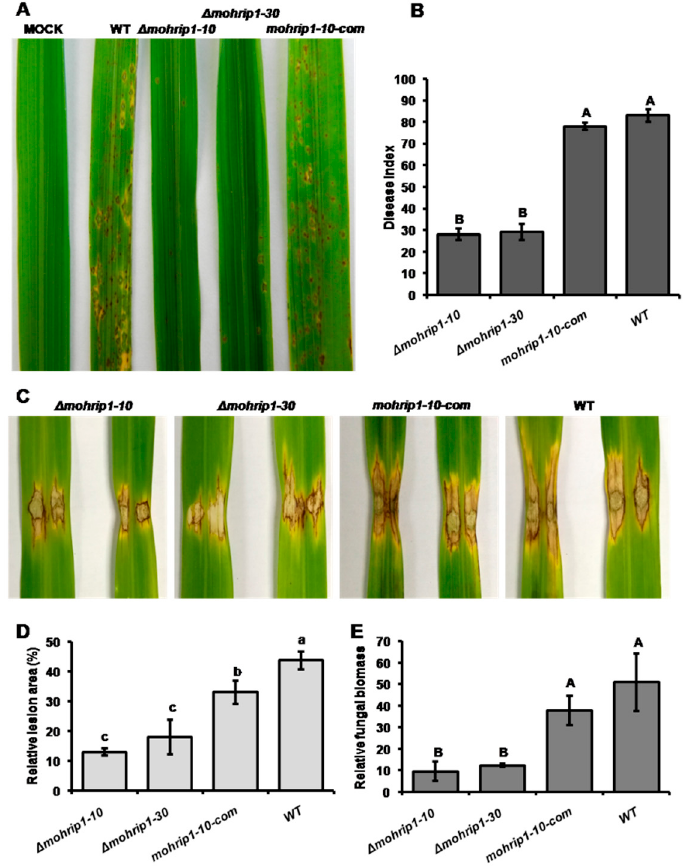
Figure 4. Pathogenicity of ∆ mohrip1 mutants. The mohrip1 deletion mutants were significantly impaired in pathogenicity. ( A ) Virulence bioassay on rice seedlings conducted by the spraying